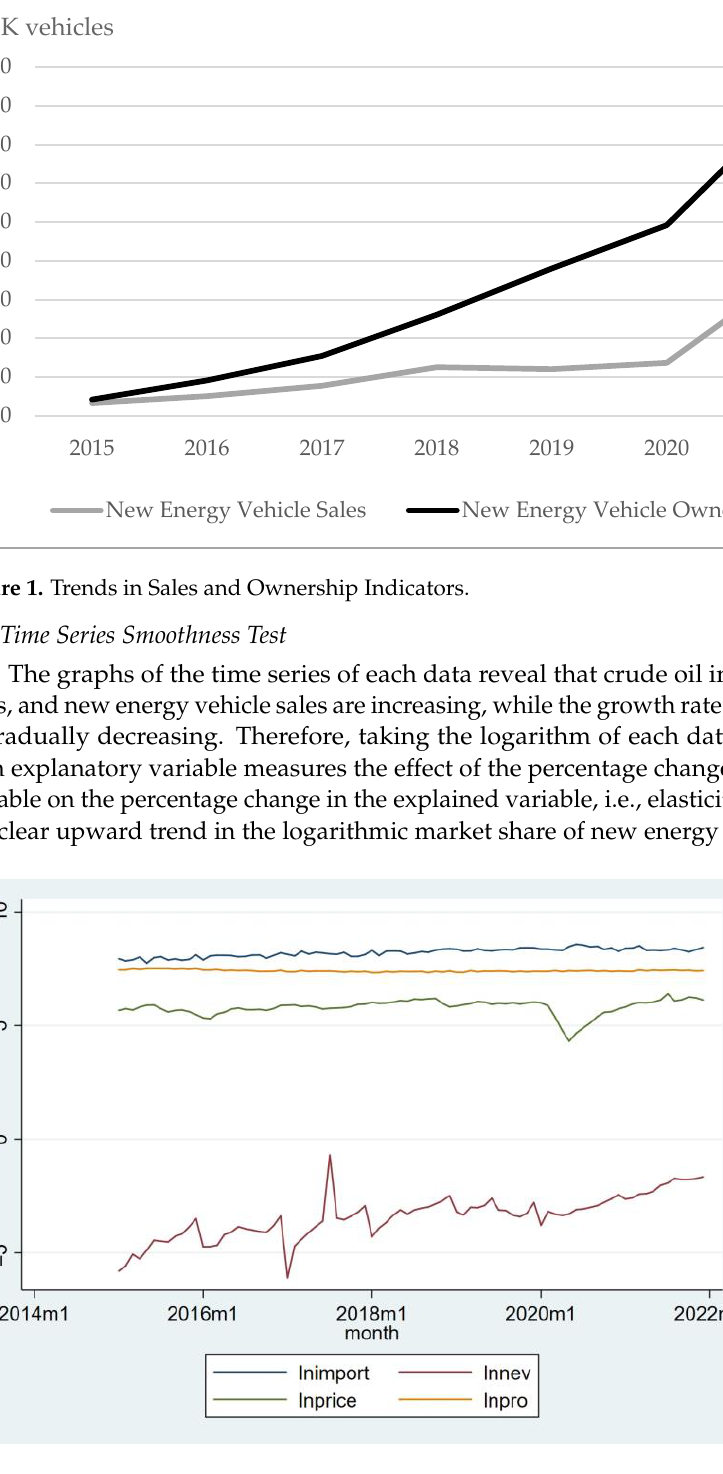
Table 1. Logarithmic ADF test for the market share of new energy vehicles. Augmented Dickey–Fuller Test for Unit Root